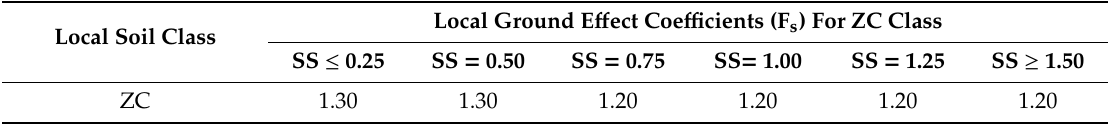
Table 4. Local soil coe ffi cient F S for short period zone for ZC [6].